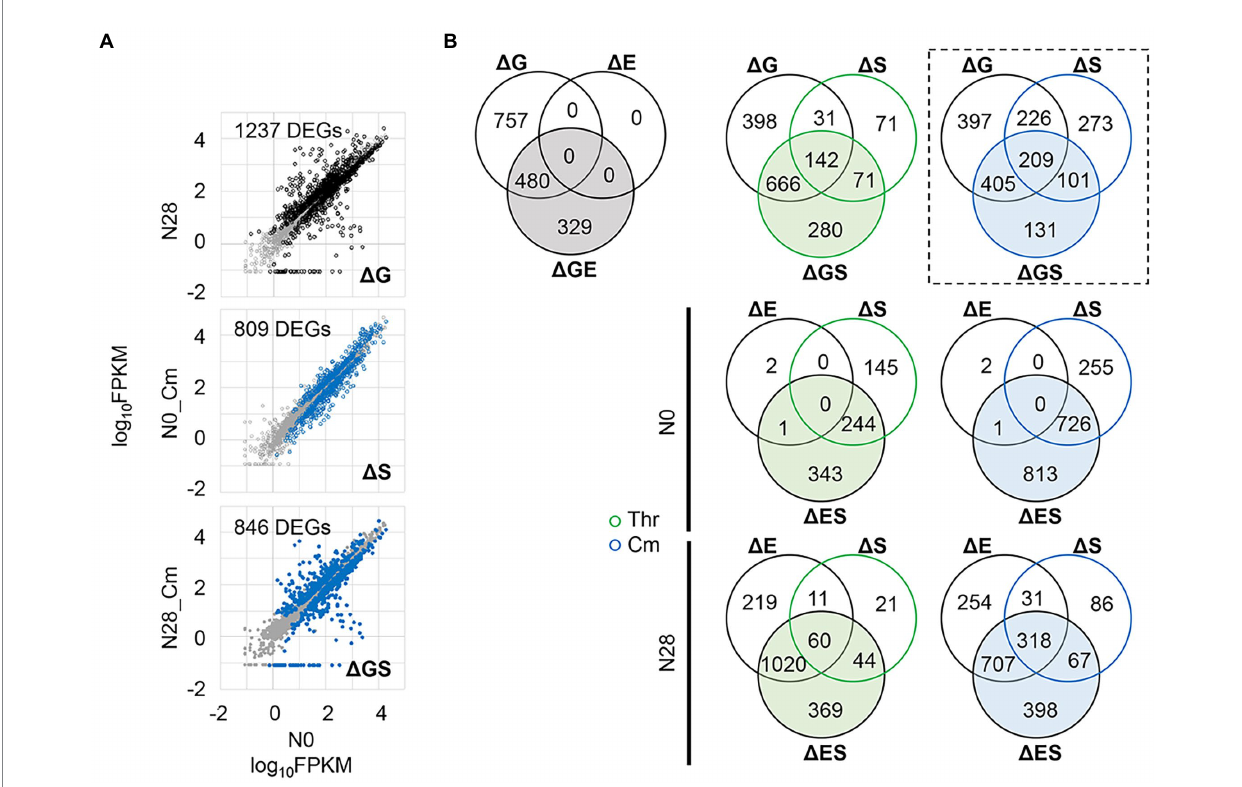
FIGURE 5 Differentially expressed genes (DEGs). (A) An example of identified DEGs. The comparisons of the Δ G-, Δ S-, and Δ GS-mediated changes are shown, in which the number of DEGs is indicated. The DEGs and the other genes are highlighted (in black or blue) and shown in gray, respectively. The gene expression level is shown on a logarithmic scale. (B) Venn diagram of DEGs. The numbers of the DEGs mediated by single and dual interruptions are shown. Green and blue indicate the addition of Thr and Cm in the culture, respectively. The box in broken lines indicates the example shown in A